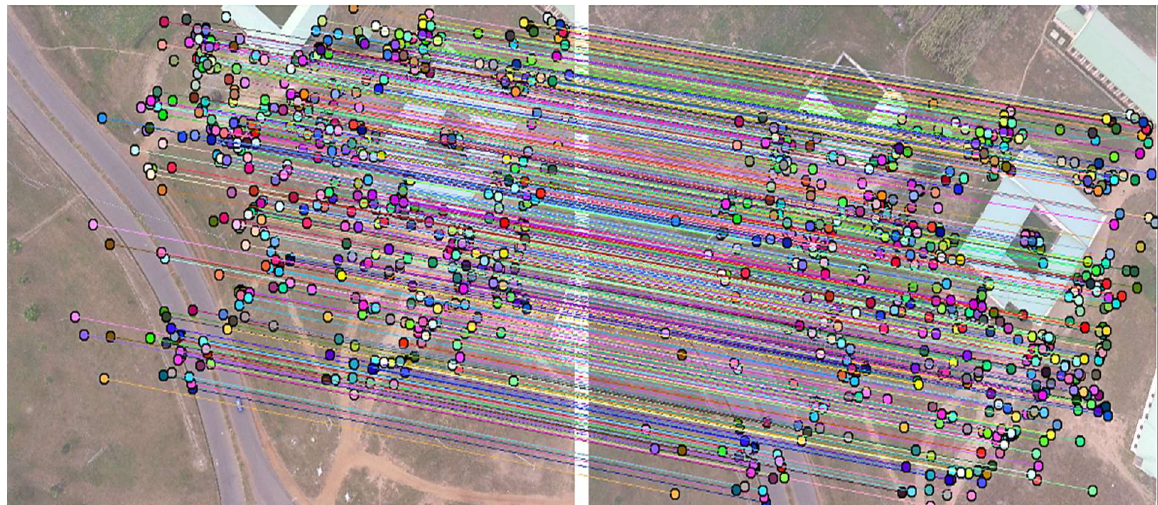
Figure 5b: Matched inliers using Speeded Up Robust Features Algorithm (SURF)